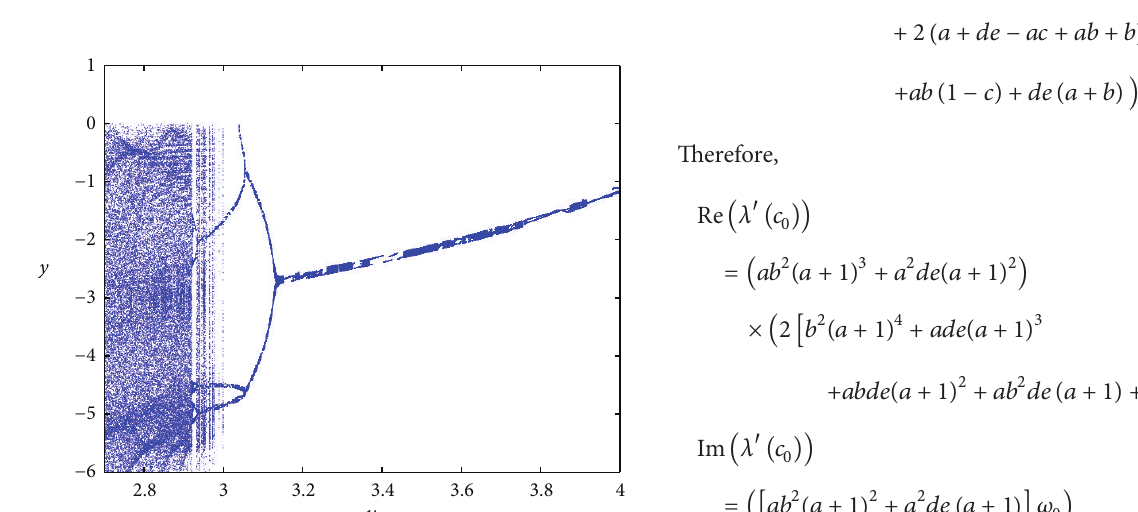
Figure 11: Complete hyperchaotic attractor in 𝑥 1 − 𝑥 2 plane (𝑢 = 0.2) .